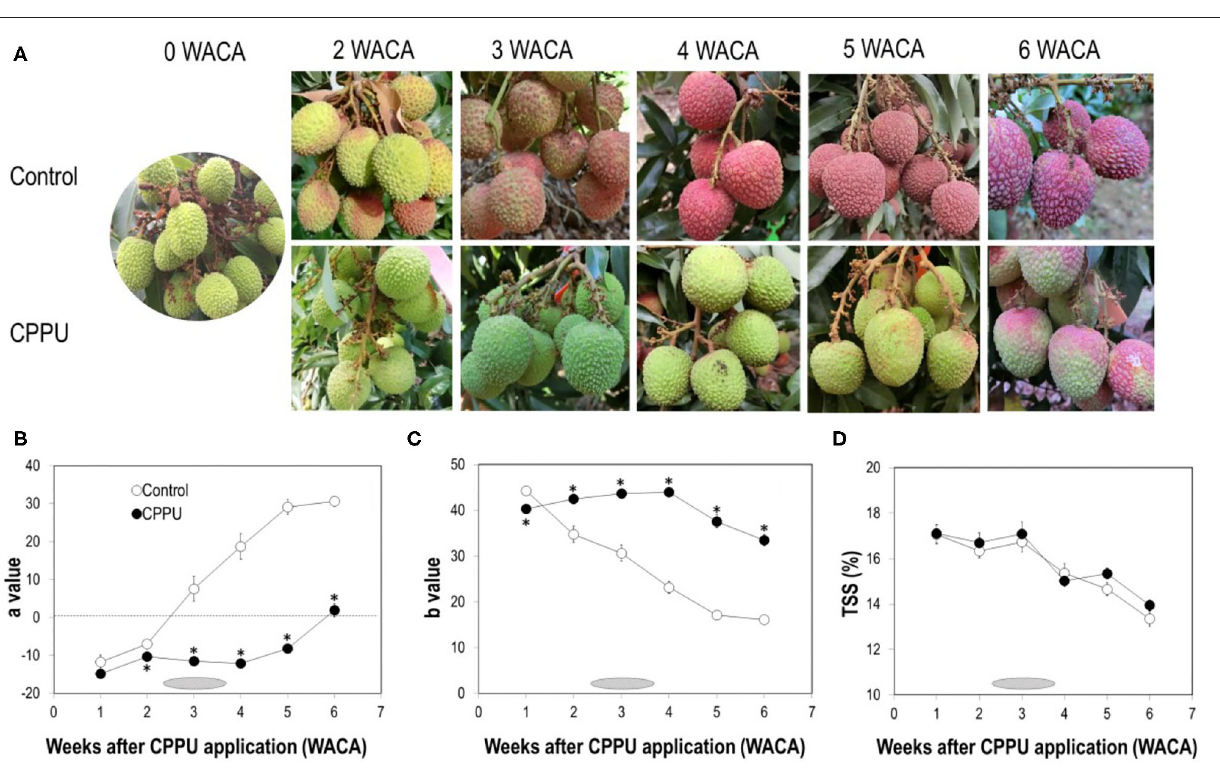
FIGURE 1 | Effect of CPPU treatment on fruit appearance (A) , color values a (B) and b (C) and TSS (D) . Shaded horizontal bars indicate commercial harvesting period which started from the end of the 2nd week to the beginning of the 4th week after CPPU treatment. Vertical bars at data points indicate standard error ( n = 5). Statistical analysis was conducted using Student’s t -test. *Indicates significant difference between CPPU treatment and the control at p <